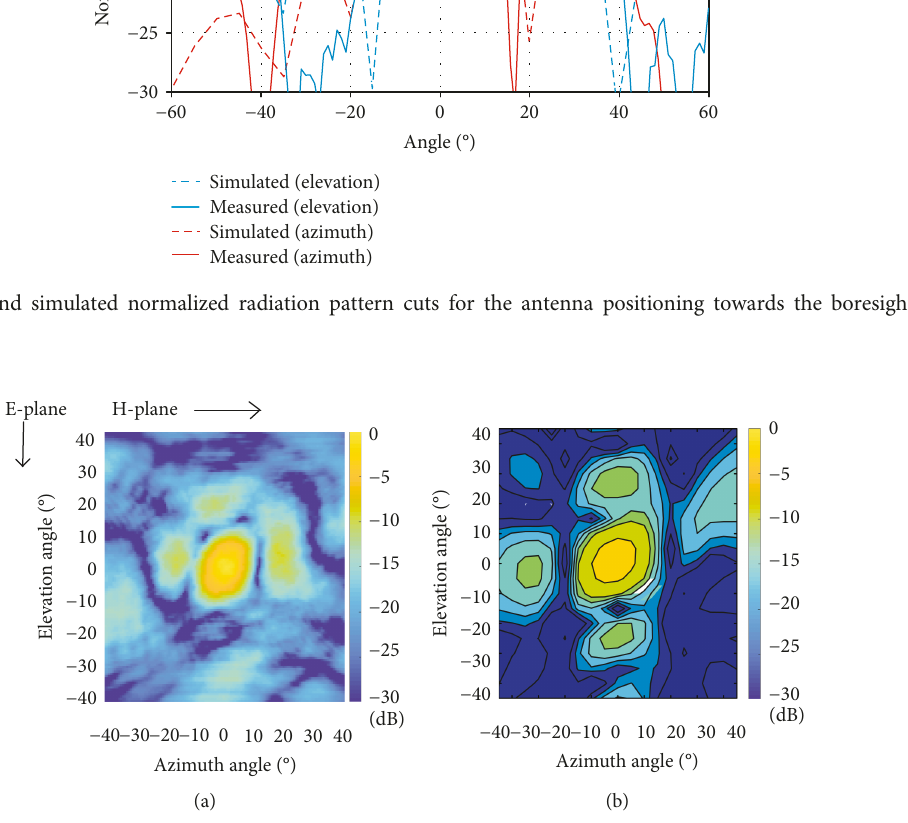
Figure 16: Measured and simulated normalized 2D radiation patterns for the antenna pointing towards the boresight direction at 72.5GHz. Table 3: Simulated and measured antenna characteristics for di ff erent beam-steering angles at